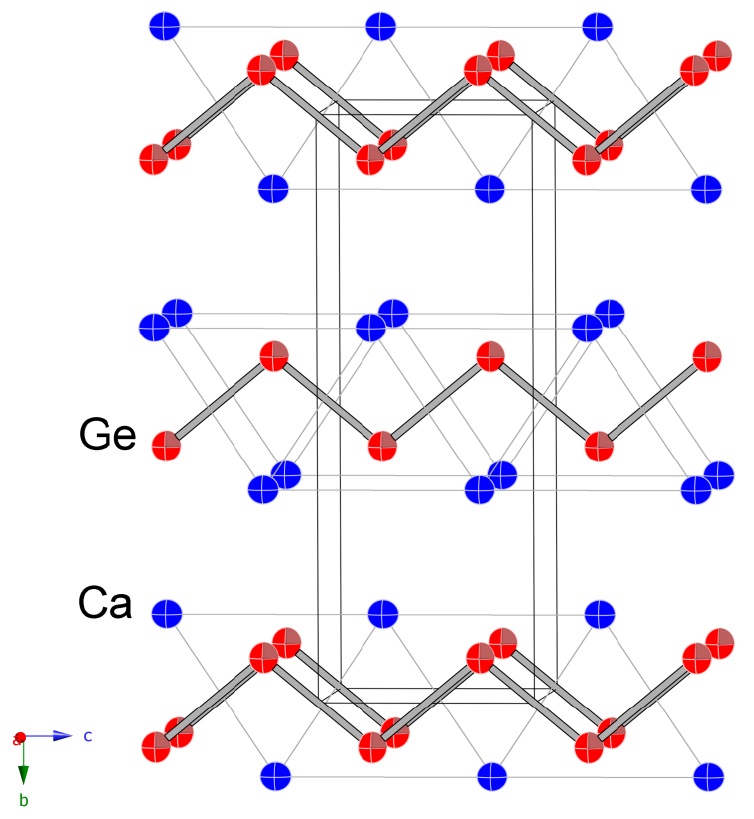
Figure 1. Off [100]-view of the crystal structure of CaGe, emphasizing the Ge zigzag chains and the packing of the metal-atom polyhedra. The unit cell is outlined. Thermal ellipsoids are drawn at the 95% probability level. Table 3. Selected interatomic distances (Å ) in CaGe. Only the shortest Ca – Ca contacts are shown, the rest are 3.9 Å and longer.